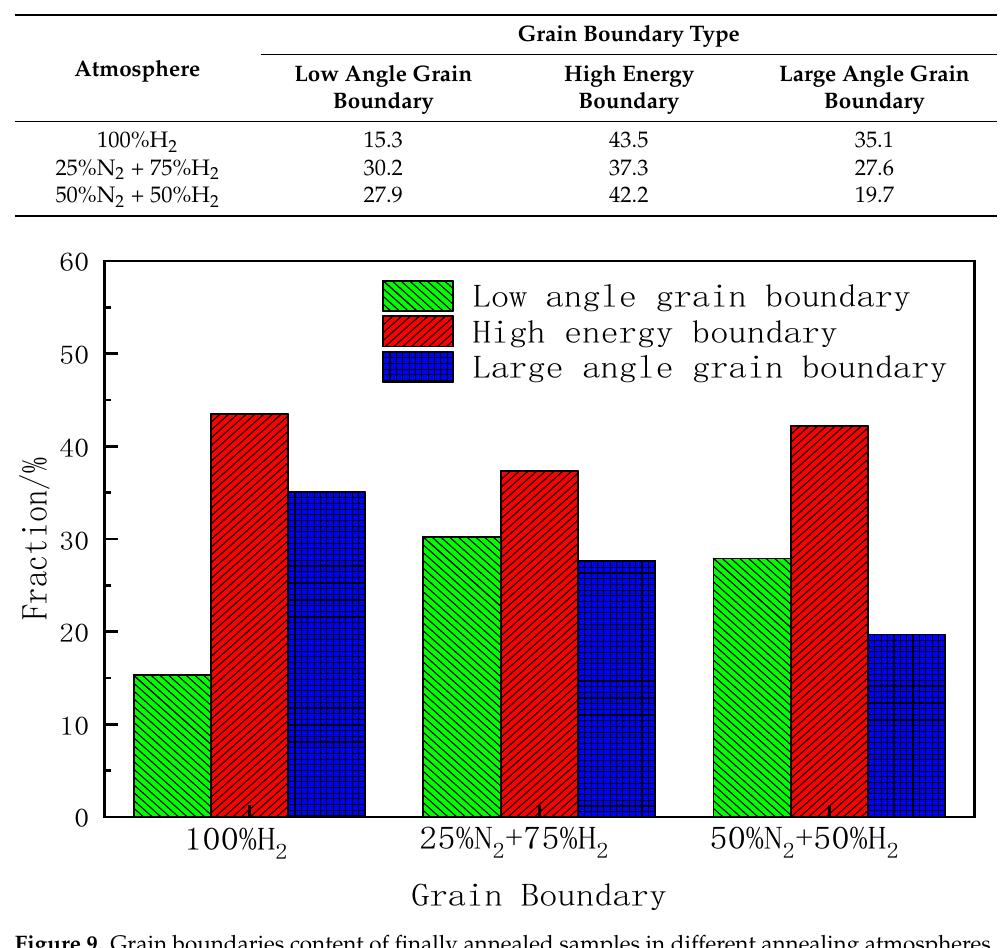
10 of 13 Figure 8. Grain boundaries of finally annealed samples in different atmospheres: ( a ) 100%H 2 ; ( b ) 25%H 2 + 75%N 2 ; ( c ) 50%N 2 + 50%H 2 . Table 3 shows the main grain boundary content of the samples annealed at a high temperature in different atmospheres. Figure 9 shows the content distribution of the main grain boundary of the samples annealed at a high temperature in different atmospheres. Combining Table 3 and Figure 9, it can be seen that when the annealing atmosphere is 100%H 2 , the content of the low-angle grain boundary is very small; the content of the high- energy grain boundary is much higher, with the content of 43.5%. This is mainly due to the lack of inhibition of the inhibitor during high-temperature annealing, which results in the growth of a large number of primary recrystallization grains with the textures such as {111}<112>, {411}<148>. These textures mainly form high-energy grain boundary with Goss textures. However, due to the reduction in the dislocation and sub-structure during